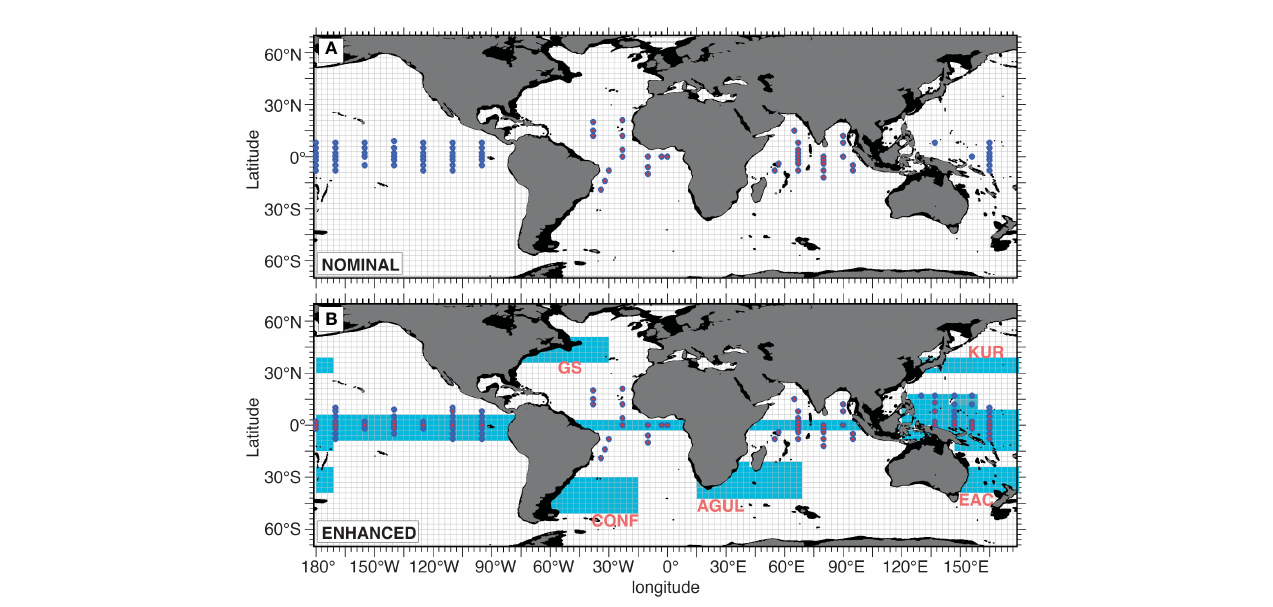
FIGURE 2 Nominal (A) and enhanced (B) con fi gurations of synthetic temperature and salinity (T/S) pro fi les for Argo fl oats (shading) and tropical moorings (dots). Argo sampling corresponds to 1 and 2 fl oats per 3°x3°x10-day square in yellow and light blue, respectively. Subsurface T/S observations from moorings are indicated by blue (T) and red (S)